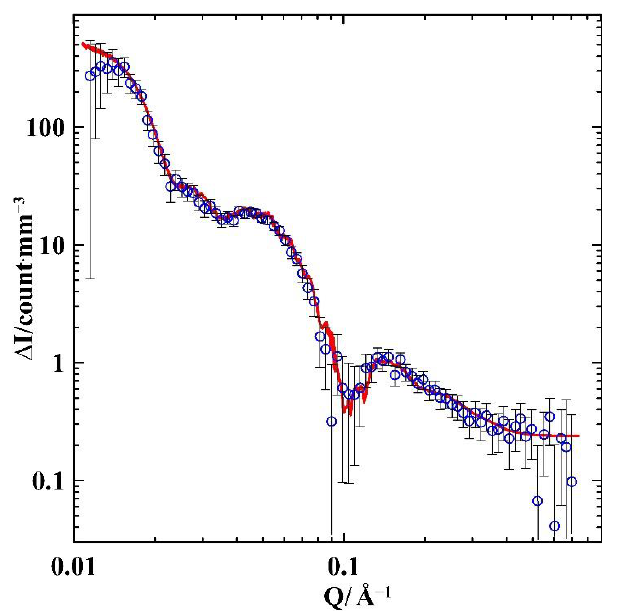
( ) QI  Q on . Blue symbols are data calculated from experiments.